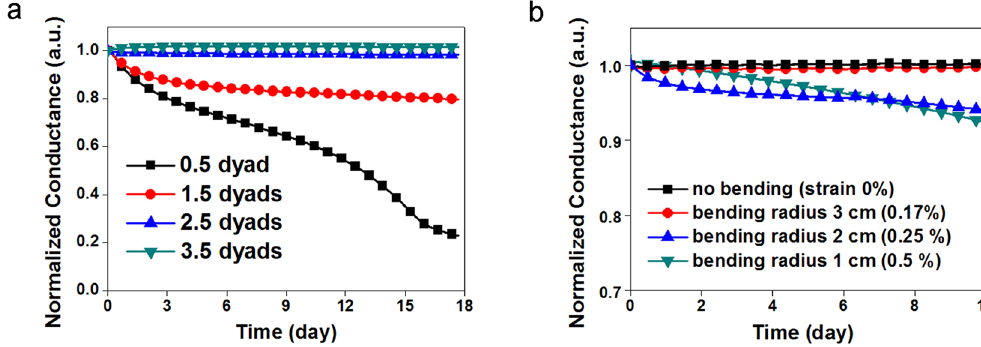
Figure 3. Calcium corrosion test: ( a,b ) Normalized conductance levels of a calcium pad over time, ( a ) according to the number of dyads, ( b ) according to the bending strain.